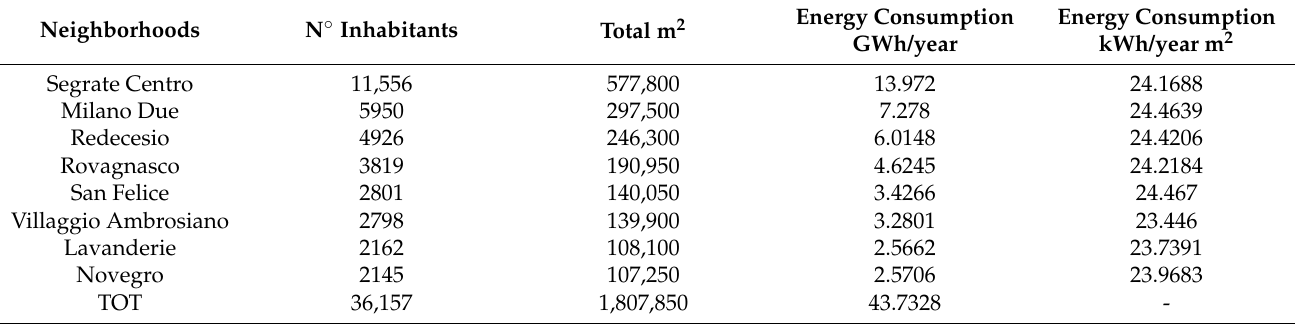
Table 1. Energy consumption and energy consumption per square meter for each Segrate